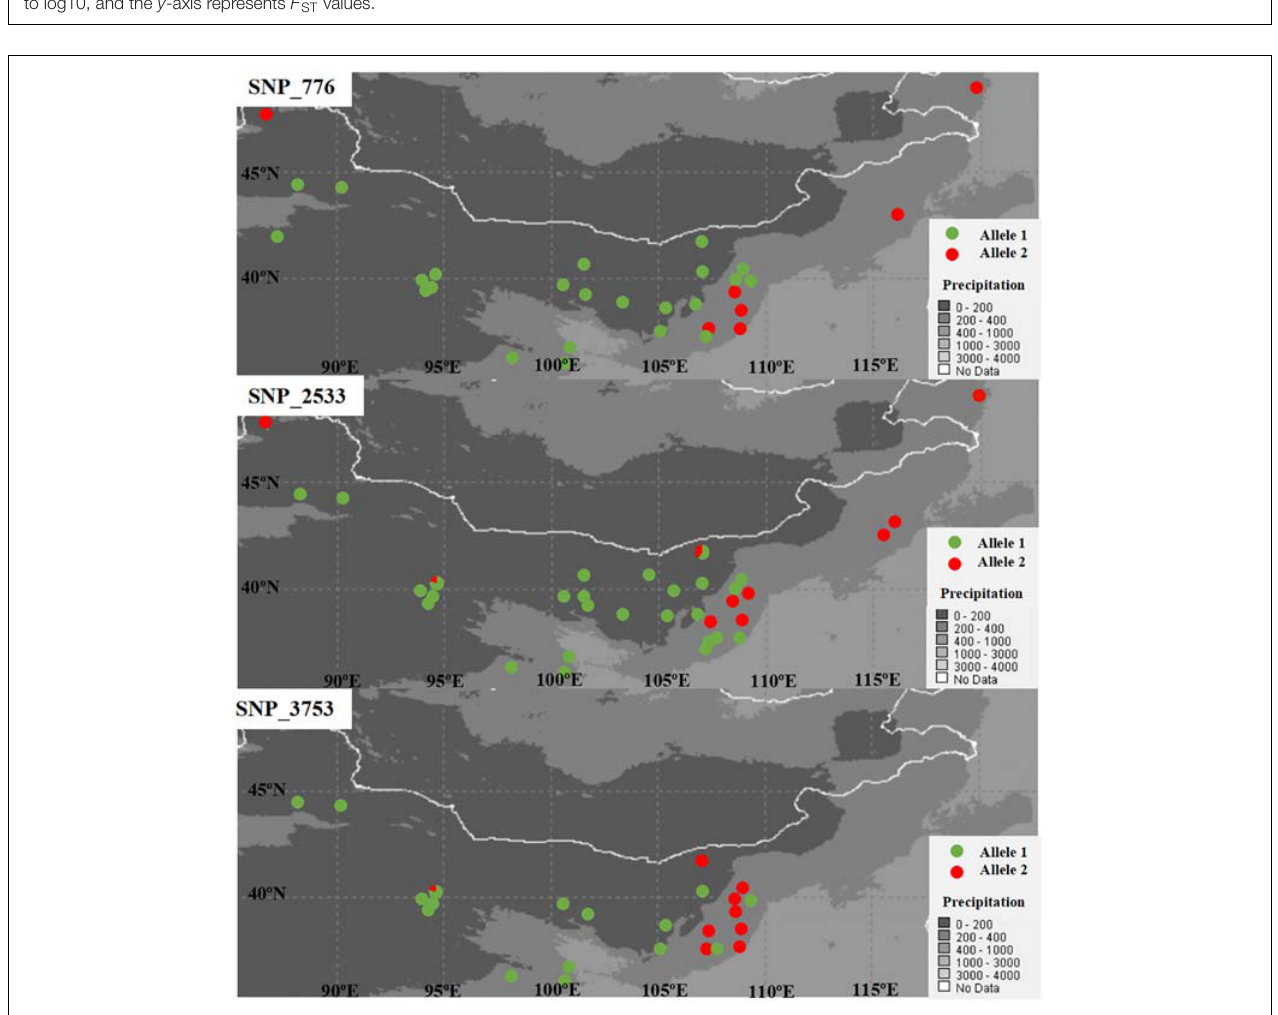
FIGURE 3 | Plots of allele frequency in each population for the three detected SNPs under diversifying